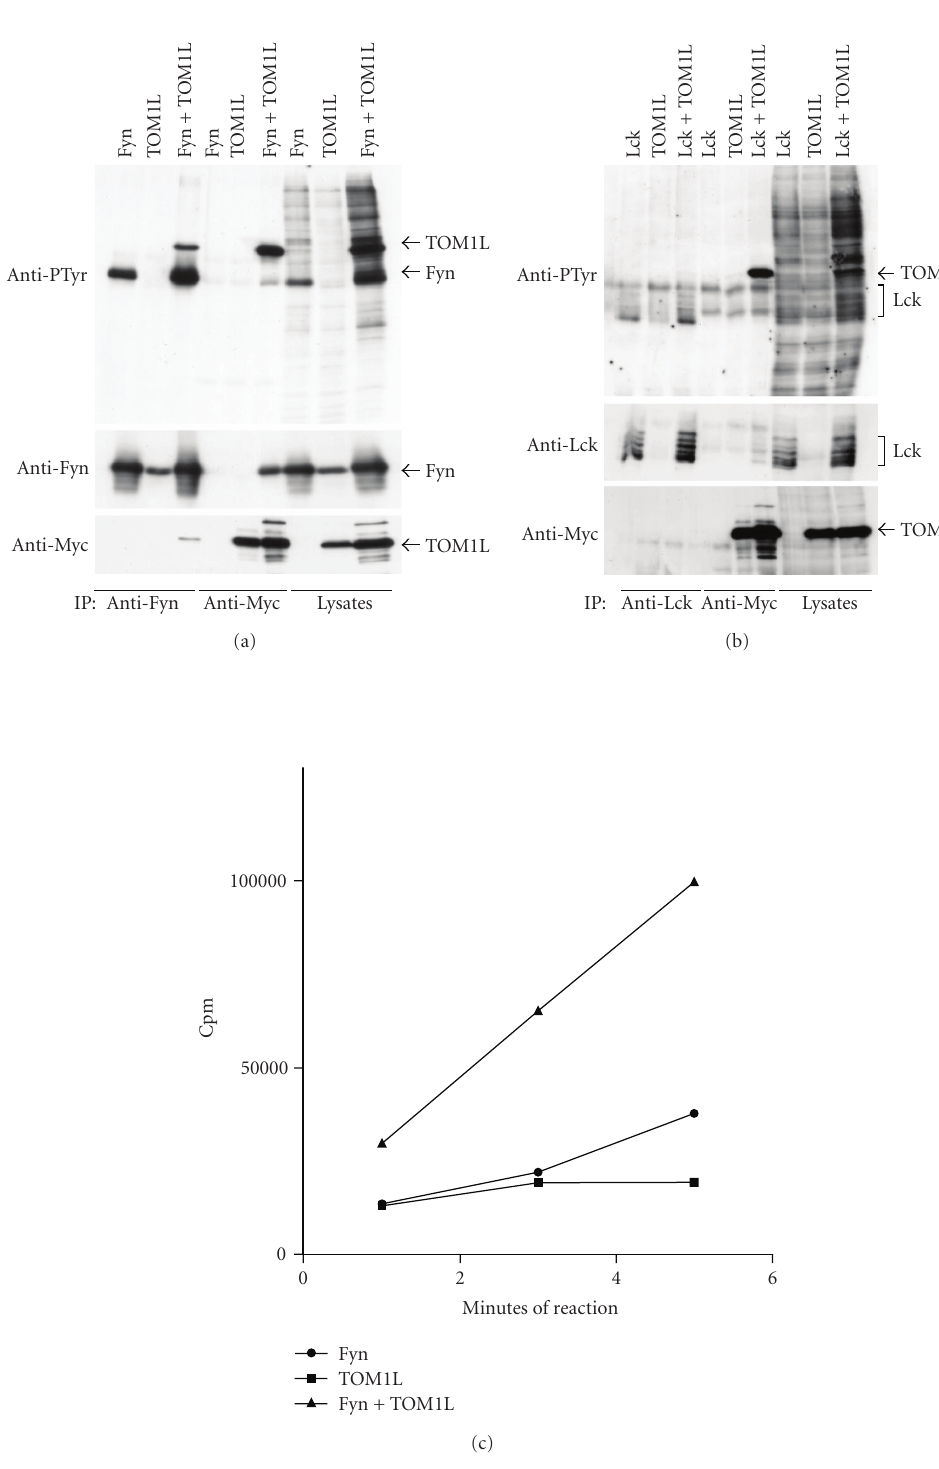
Figure 2: (a) 293T cells transfected with plasmids encoding Fyn alone or together with Myc-tagged full length TOM1L. Fyn and TOM1L proteins were isolated by immunoprecipitation using anti-Fyn, or anti-Myc antibodies and assayed by SDS − PAGE and immunoblotting as described in material and methods. Immunoblots were analyzed with primary anti-phosphotyrosine (anti-PTyr), anti-Fyn or anti-Myc –antibodies, respectively. (b) 293T cells transfected with plasmids encoding Lck alone or together with Myc-tagged full length TOM1L. Lck and TOM1L proteins were isolated by immunoprecipitation using anti-Lck or anti-Myc antibodies and assayed by SDS − PAGE and immunoblotting as described in material and methods. (c) Kinase assay: Anti-Fyn immunoprecipitates were incubated with 5 μ Ci of ( γ -32P) ATP and 2mM (Val5)-angiotensin II as an exogenous substrate in PIPES kinase bu ff er for 1, 3, and 5 minutes at room